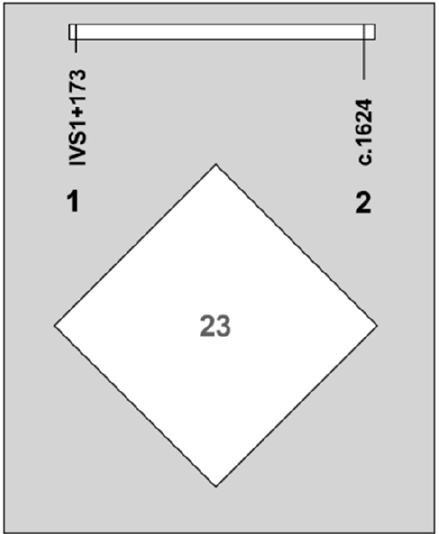
Figure 1. Linkage Disequilibrium of ICOS . The haplotype linkage disequilibrium (LD) was calculated with SHEsis program. D’ value of 100 shows a complete LD and a value of 0 shows a complete linkage equilibrium. ICOS block shows a low LD (D’ = 23, r 2 = 0.042).